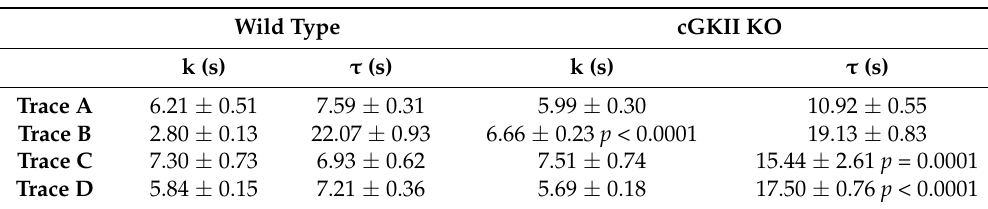
Table 1. Time constants of exocytosis and endocytosis for the different traces in response to brief